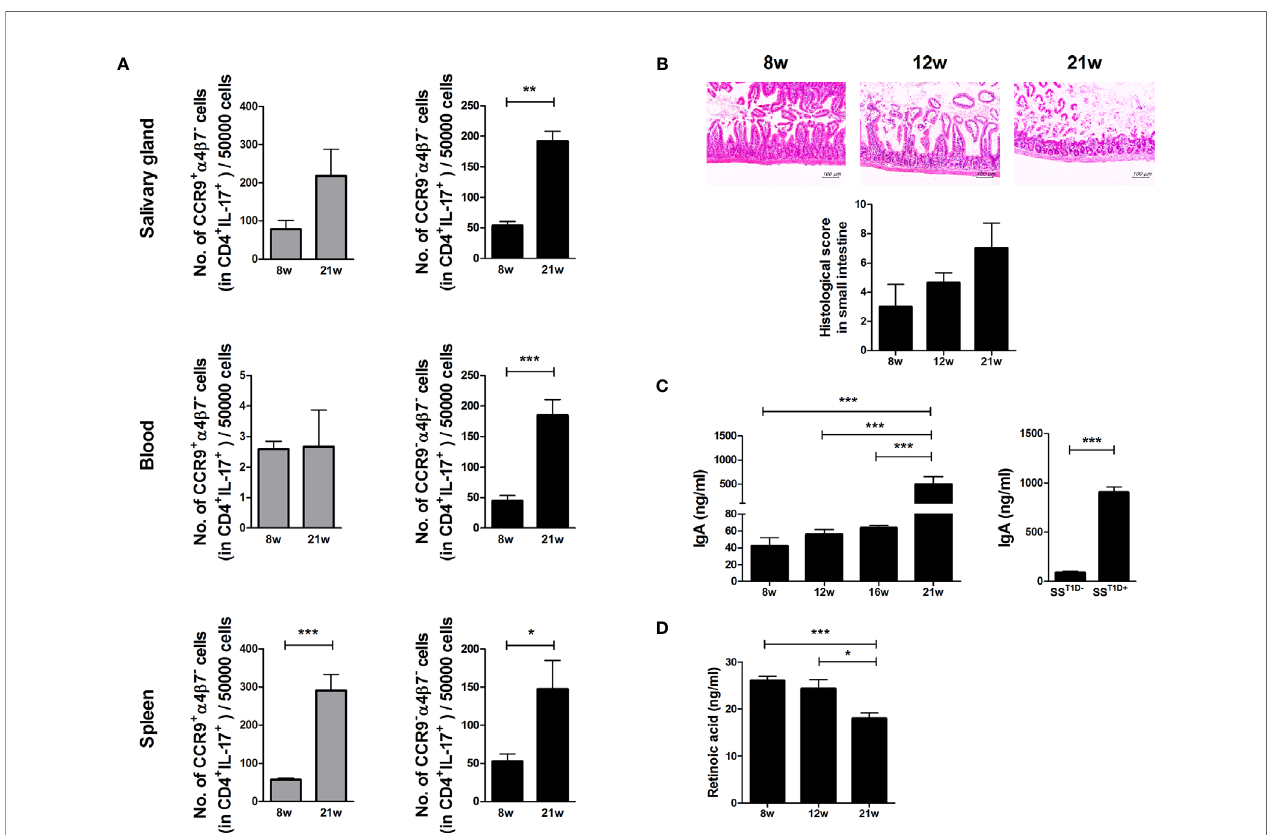
FIGURE 3 | Regulation of small intestinal in fl ammation and gut-homing molecules expression in Th17 cells due to retinoic acid (RA) de fi ciency in aged mice. (A) Bar graphs show average numbers of CCP9 + a 4 b 7 – (left) and CCP9 – a 4 b 7 – (right) cells among cells isolated from salivary glands (top), peripheral blood (middle), and spleens (bottom) of 8- and 21-week-old NOD/ShiLtJ mice. Cells were stimulated with PMA and ionomycin for 4 h and GolgiStop for the fi nal 2 h, and then stained with the indicated antibodies for fl ow cytometry analysis (N=5). (B) Representative H&E-stained images of small intestines from NOD/ShiLtJ mice at the indicated ages. Bar graph shows average histological scores (N=5). Scale bar= 100 µm. (C) Bar graphs show average IgA levels in sera from NOD/ShiLtJ mice at the indicated ages (left) and SS mice with or without T1D (right) (N=5). (D) Bar graph shows average retinoic acid levels in sera from NOD/ShiLtJ mice at the indicated ages (N=5). Values are means ± SEM from three independent experiments. * p < 0.05, ** p < 0.01, *** p <